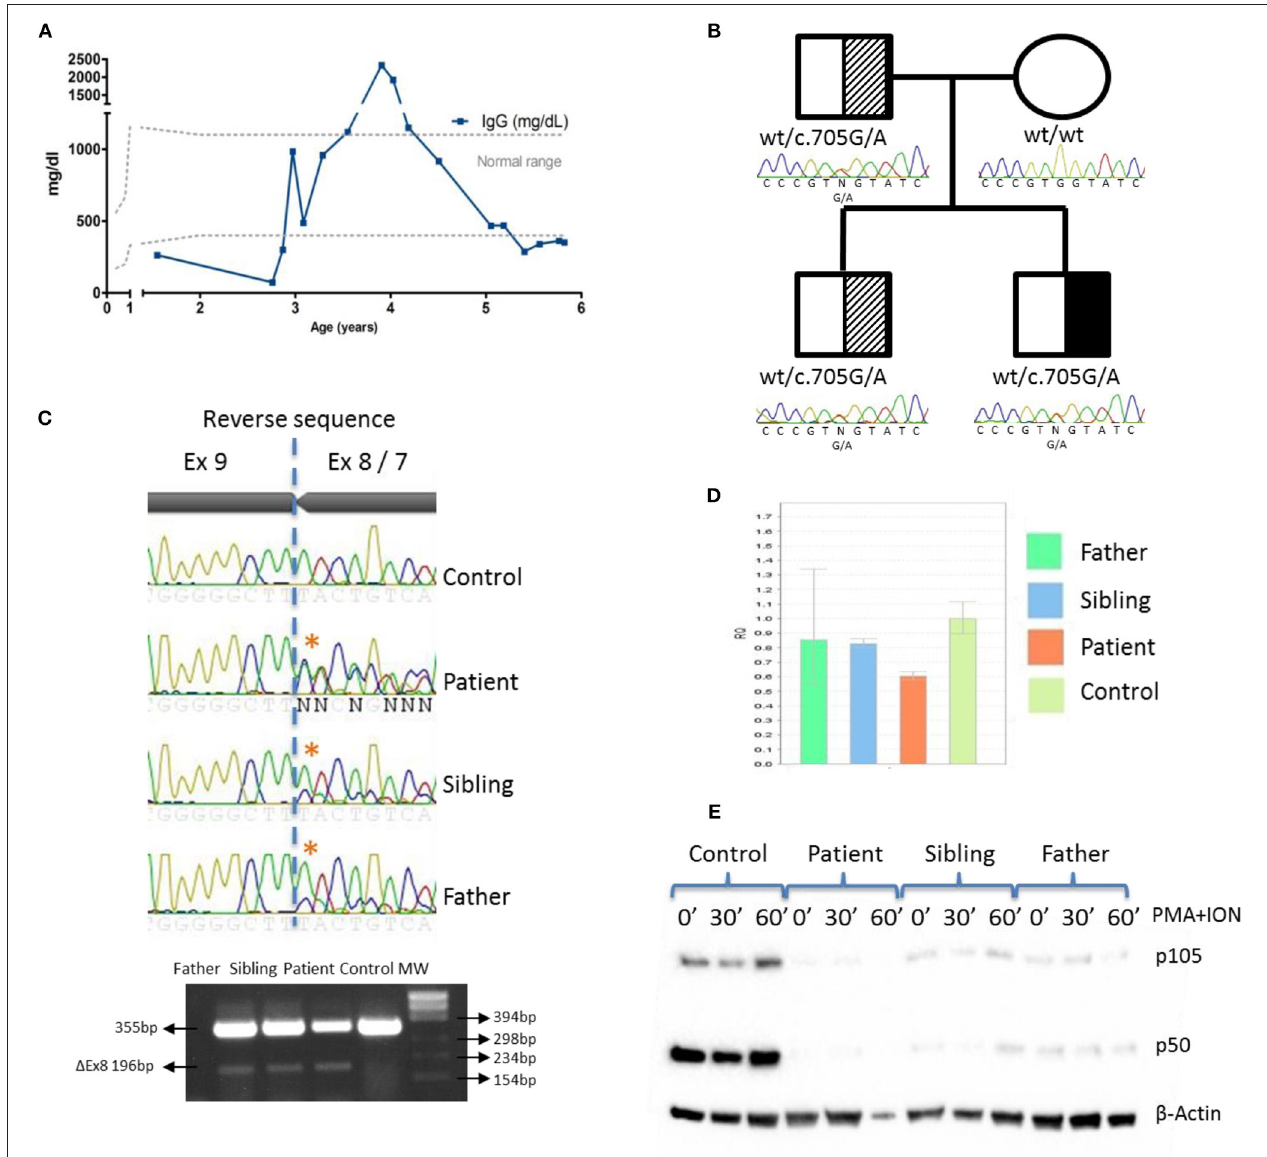
FIGURE 2 | IgG levels and genetic and functional evaluation in a patient with NF- κ B1 deficiency. (A) Serum IgG concentrations over time. (B) Pedigree and genomic sequencing of c.705G > A NFKB1 gene variant. Black represents the affected individual (patient). Shaded represents asymptomatic carriers; (C) Sanger sequencing and RT-PCR amplification of NFKB1 mRNA showing exon 8 skipping; (D) NFKB1 expression from patient, father and sibling relative to controls by qRT-PCR; (E) The mutation led to reduced expression of p105 and p50 upon stimulation with PMA + ION in patient, father and sibling by western blotting.